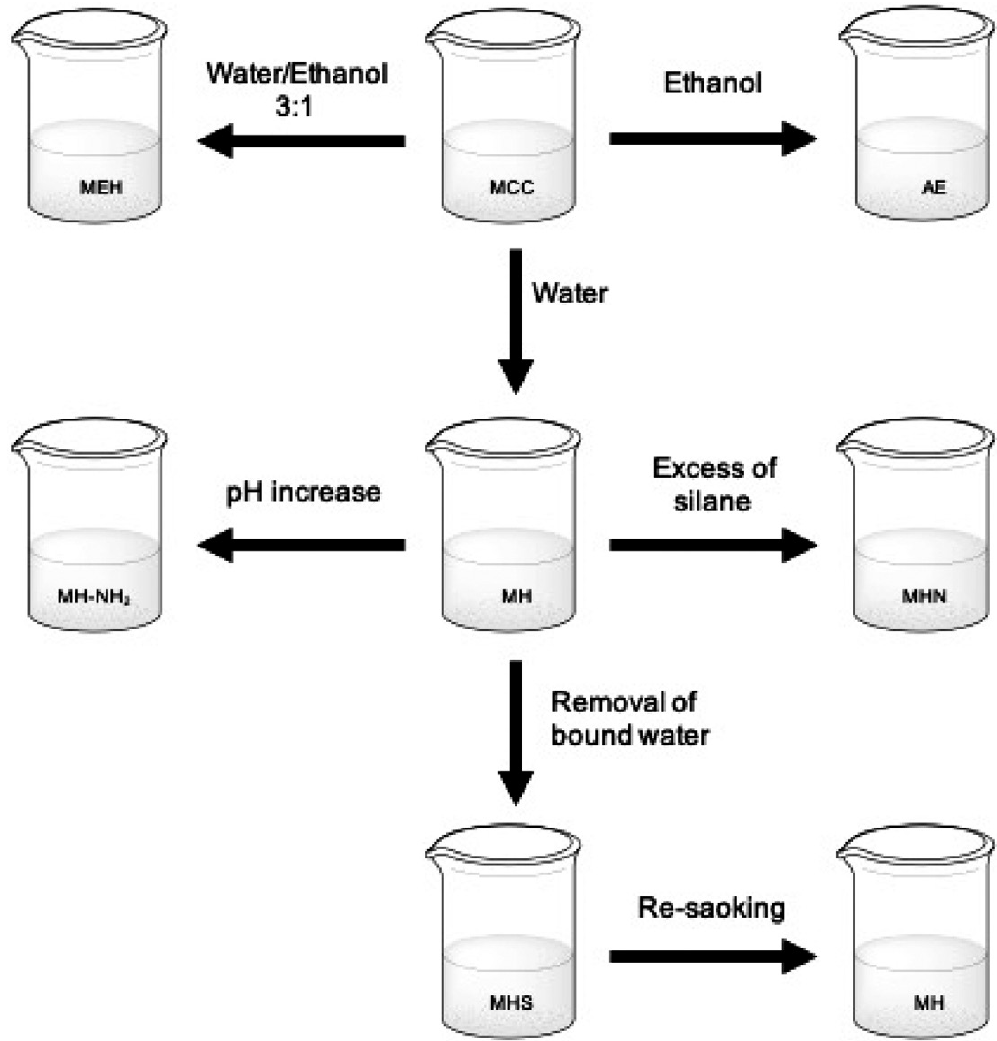
Fig. 1 Flowchart of chemical modification of